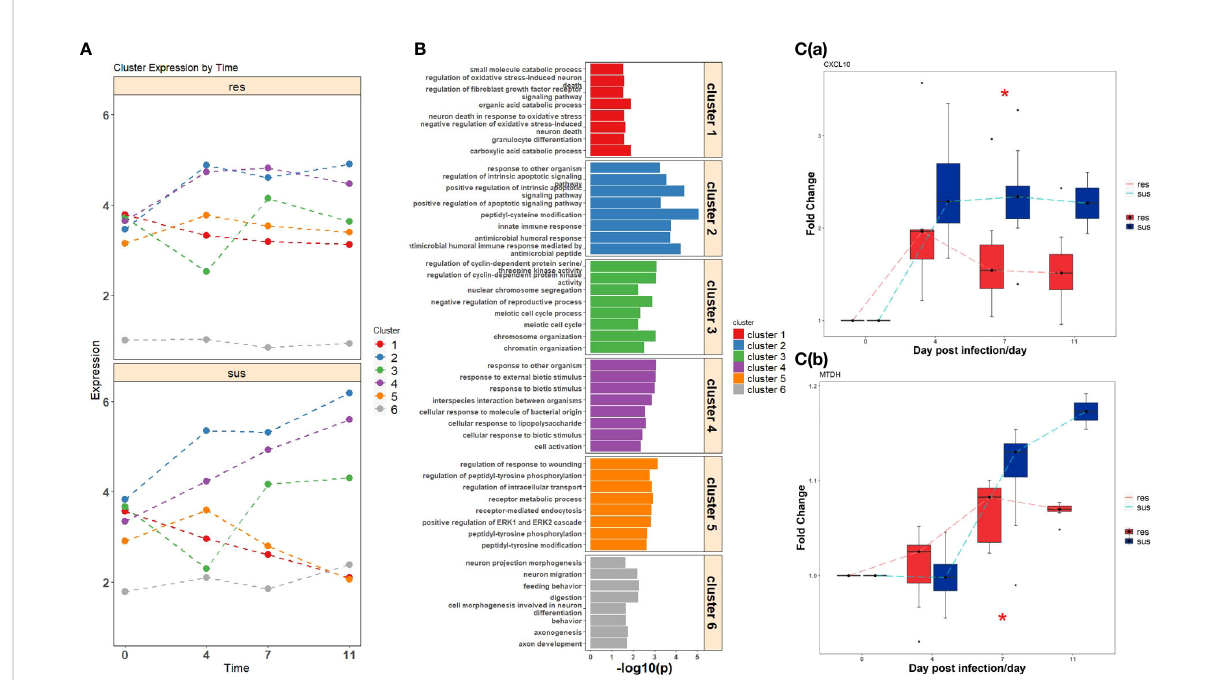
FIGURE 4 (A) Temporal expression patterns of clustered DEGs in resistant (top) and susceptible (bottom) pigs post infection. (B) Gene ontology enrichment analyses of DEGs within clusters. (C) The expression values of signi fi cant DEGs related to immune response between resistant (red) and susceptible (blue) pigs; (a) CXCL10, (b) MTDH. Signi fi cance level is shown by *, p-value <